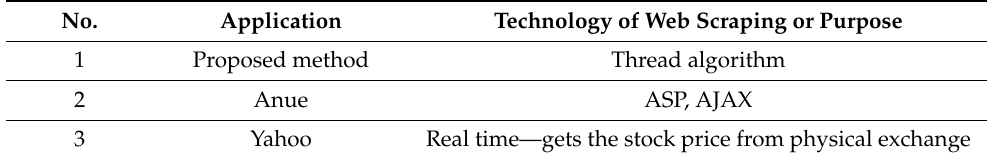
Table 3. Stock-scraping comparative stock service